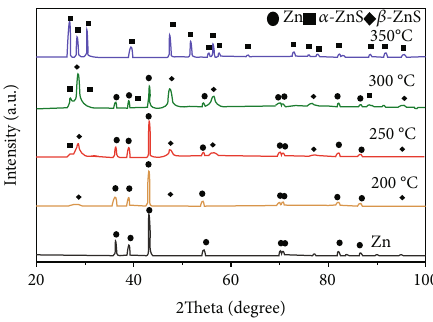
Figure 2: XRD spectra of the ZnS materials at di ff erent sulfurization